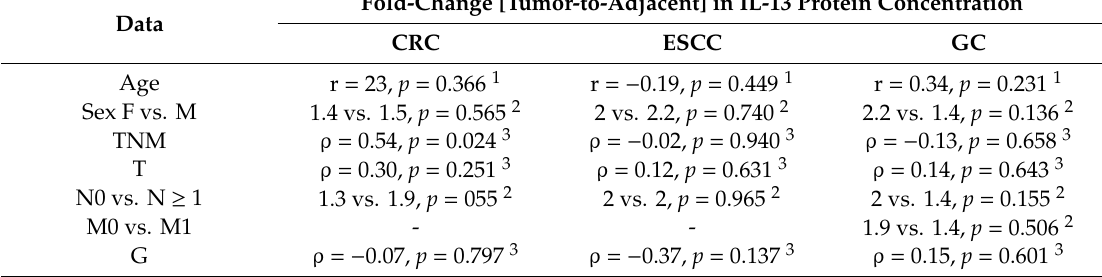
Table 6. Association of demographic and pathological data with IL-13 protein concentration in the GIT cancer patients.